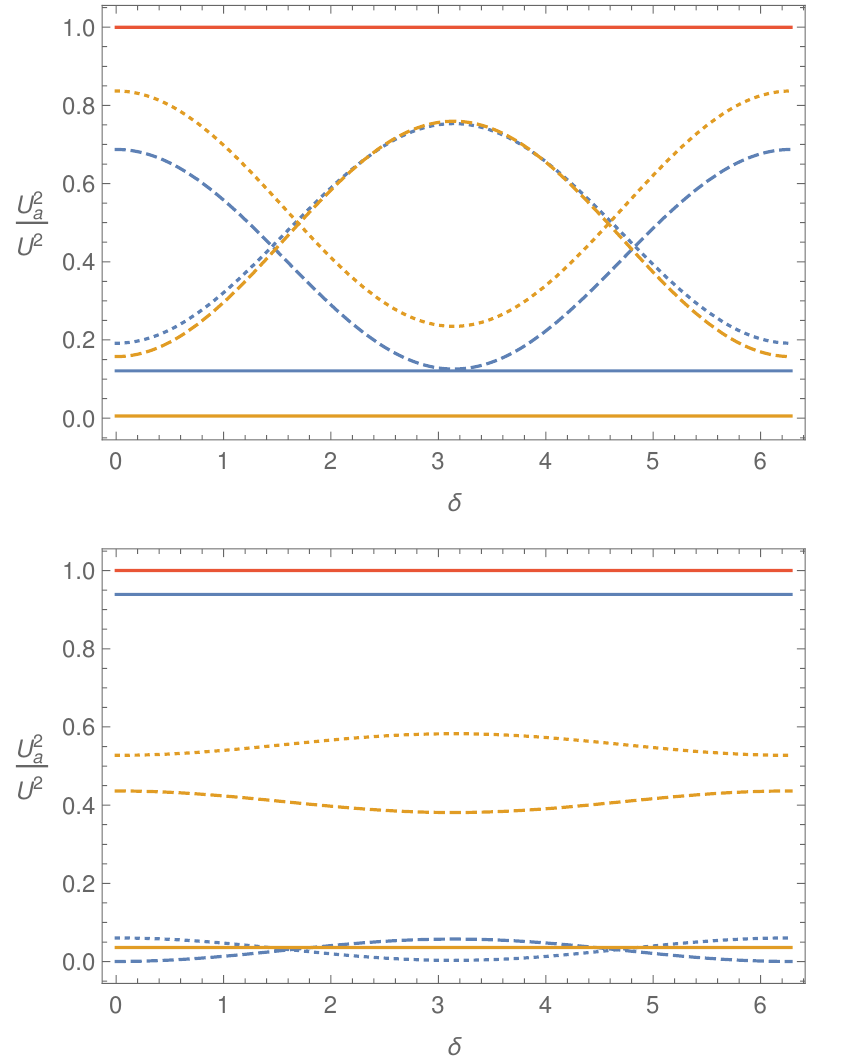
Figure 12 . Relative mixing U 2 =U 2 over (cid:14) with a = e; (cid:22); (cid:28) for n s = 2 sterile (cid:13)avours in the limit of a large Im ! , cf. eq. (2.9). The electron mixings are given by solid lines, the muon mixings by dashed and the tauon mixings by dotted lines. The red line corresponds to the total mixing U 2 = P The upper panel assumes normal hierarchy, where the orange and blue curves indicate the cases (cid:11) 2 = (cid:0) 2 (cid:14) + (cid:25) and (cid:11) 2 = (cid:0) 2 (cid:14) + 3 (cid:25) , respectively. The lower panel corresponds to inverted hierarchy, where the blue and orange curves indicate the cases (cid:11) 2 = (cid:25) and (cid:11) 2 = (cid:0) (cid:25) , respectively.